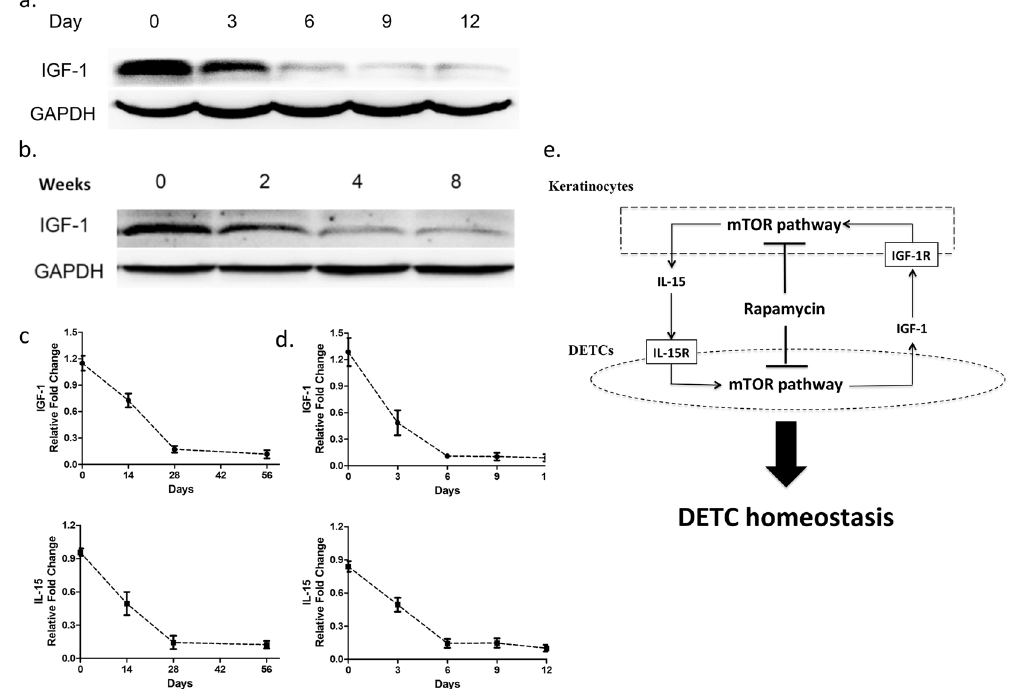
Figure 6. Both productions of IGF-1 and IL-15 in epidermis are regulated by mTOR pathway. ( a ) 6–8 weeks wild-type male C57BL/6 J mice were administered STZ daily for 6 days. At day 0 (no treatment), 3, 6, 9, and 12 after STZ treatment, epidermal sheets were obtained for detecting the production of IGF-1 by Western blotting. ( b ) Wild-type C57BL/6J mice were administered rapamycin daily for 8 weeks. At 0, 2, 4, and 8 weeks after rapamycin treatment, epidermal sheets were obtained for detecting the production of IGF-1 by Western blotting. ( c ) The kinetics of IL-15 and IGF-1 in rapamycin-treated mice is shown. ( d ) The kinetics of IL-15 and IGF-1 in STZ-treated mice is shown. All data represent at least three independent experiments and each experiment includes 6 animals (3 control and 3 experimental mice). All error bars represent mean ± SEM. * P < 0.05. ( e ) Model of signaling network that regulates wound healing during